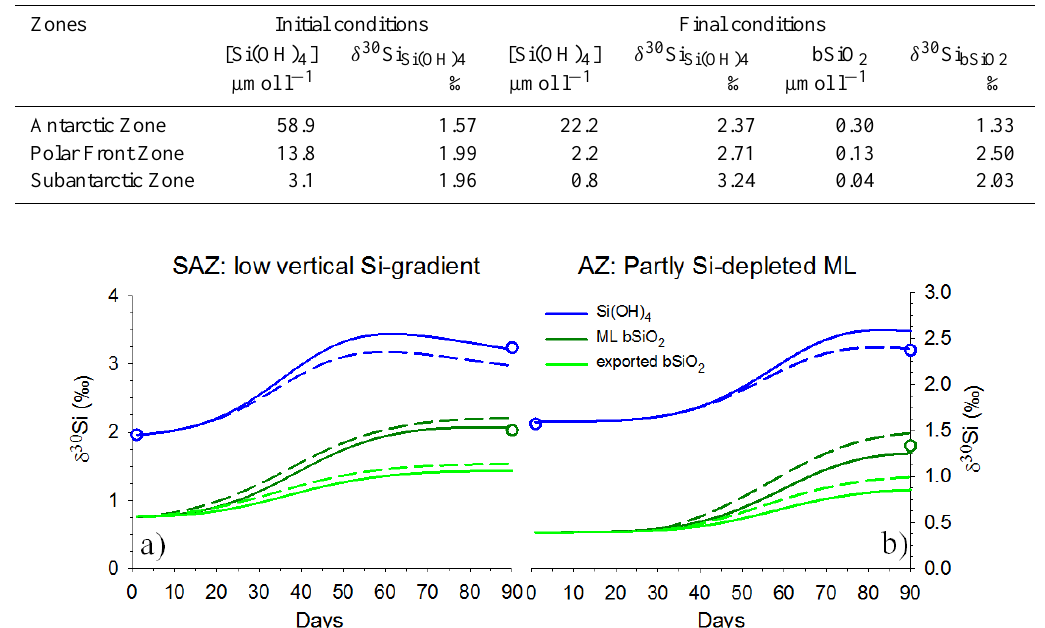
Table 2. Initial and final conditions, Si(OH) 4 and bSiO 2 concentrations and isotopic compositions, for the model run (AZ, PFZ, and SAZ). Due to their asymmetric distribution, the median value has been chosen to be representative of the central values (Fripiat et al., 2011b). The initial conditions are the subsurface water in each zone: the halocline in both the AZ and PFZ, and the thermocline in the SAZ. The final conditions are the corresponding mixed layer: respectively, super stations 2, 3, and 4 for the SAZ, PFZ, and AZ (Fig. 1).